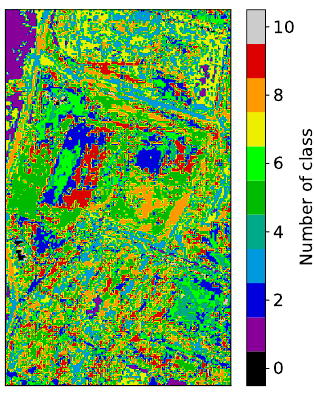
determine the reference radiance L nopl as shown by the equa- tion (5). The goal of this step is to retrieve the spectrum of each pixel if the gas plume was not present. Using morphological Figure 2. Classification of the HySpex image. The initial transformations, a mask with the pixels that surround the plume number of classes of 15 is reduced to 12 classes with the is created. For each pixel of the plume, the reference is chosen processing of pixels with few pixels. The class 0 regroups the among pixels of surrounding mask. To chose this specific pixel, pixels of classes with few pixels. 3 criteria are used : i) belonging to the surrounding mask, ii) belonging to the same class than the plume pixel, iii) having a spectrum similar to plume pixel at the wavelength not impacted by CH 4 (by minimisation of the root-mean square error RMSE). The figure 4 represents an example of the chosen spectrum to rebuild the reference image. The blue and red curves are sim- ilar outside the CH 4 range and we can observe small variations between 2.25 and 2.4 µ m. Reference spectra become available for all detected pixels.